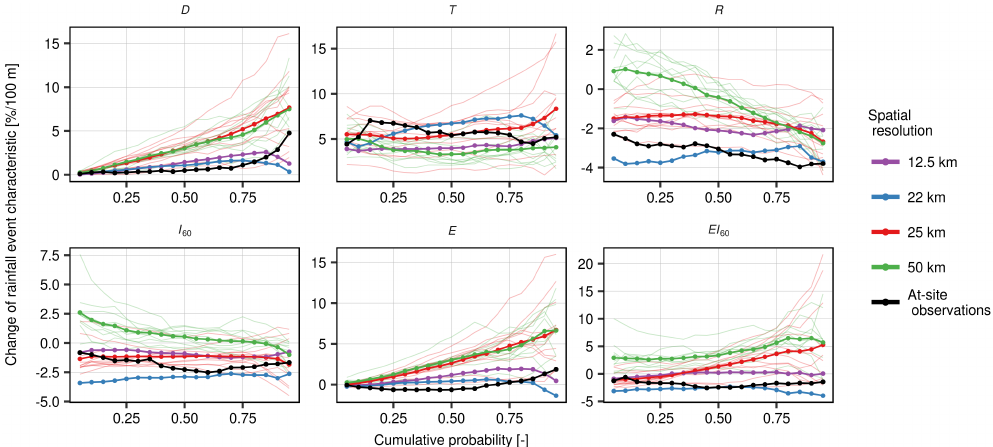
Figure 6. Dependence of rainfall event characteristics on altitude. Dependence is expressed by the change of characteristic per 100m in elevation for the corresponding probability from the empirical distribution function of the event characteristics. Spatial resolution of the RCM simulations is indicated by colour (lines with points show RCM simulations